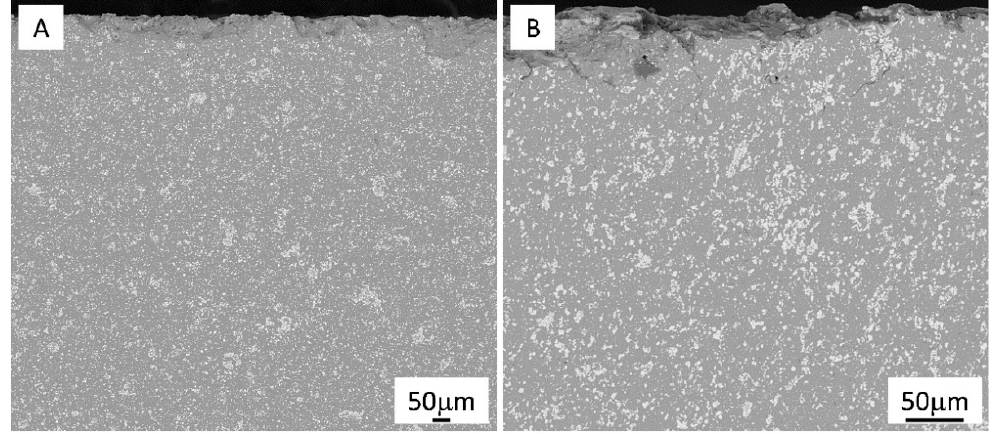
Figure 6. SEM cross-sectional view of α - β 20T ceramic after wire electrical discharge machining (WEDM) at different magnifications. ( A ) low magnification; ( B ) high magnification. Topography of the machined surface of α - β 20T ceramic is presented in Figure 7.